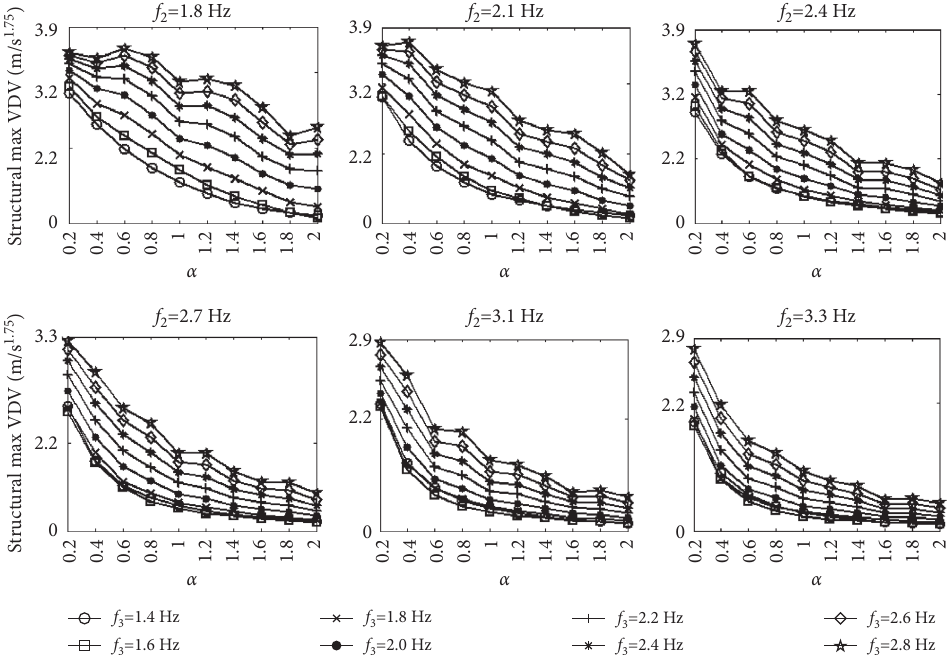
Figure 22: The influence of other f